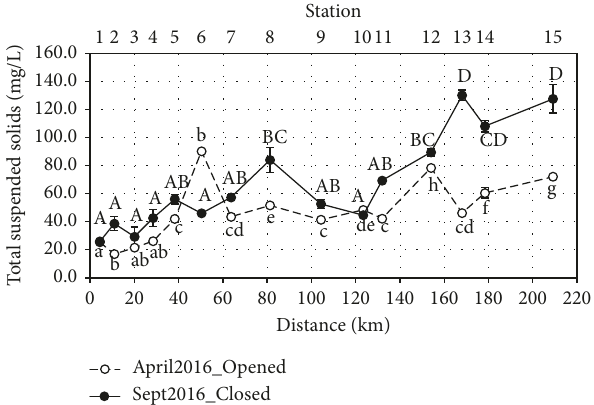
Figure 6: Turbidity at the 15 stations downstream of Bakun Hydroelectric Dam during opened spillway ( o ) and closed spillway ( • ). The same letter indicates no significant difference ( p > 0 .